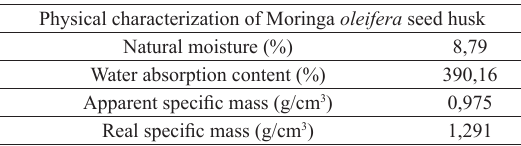
Table 4. Physical characterization of Moringa oleifera seed